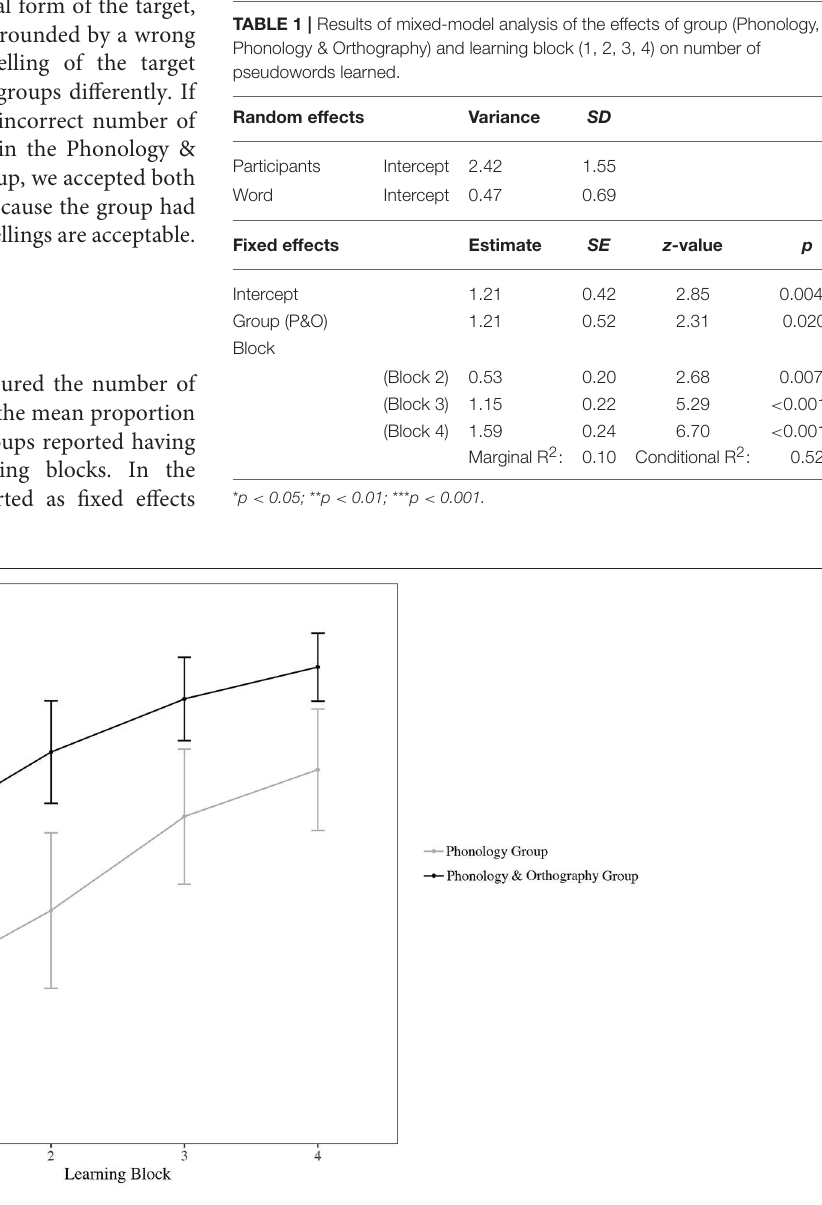
Frontiers in Communication |